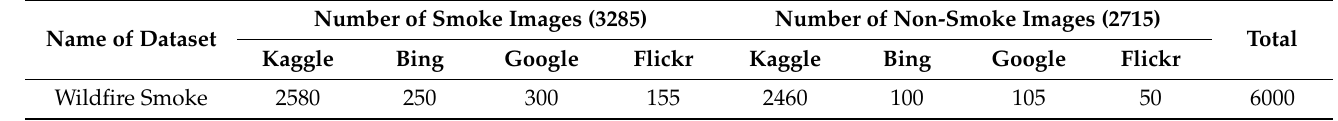
Figure 8. Image data augmentation using geometric transformations: ( a ) original image; ( b ) 60° rotation; ( c ) 120° rotation; ( d ) horizontal flipping of original image; ( e ) horizontal flipping of 60° rotated image; ( f ) horizontal flipping of 120° rotated image.